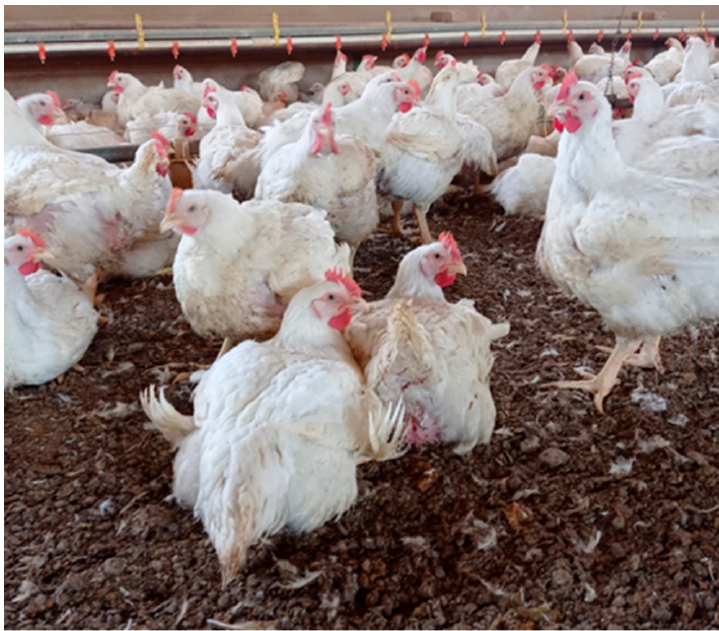
Figure 2. A picture of live birds in normal health status of the infected house 1. A laying bird shows dropping wings and curling feathers.